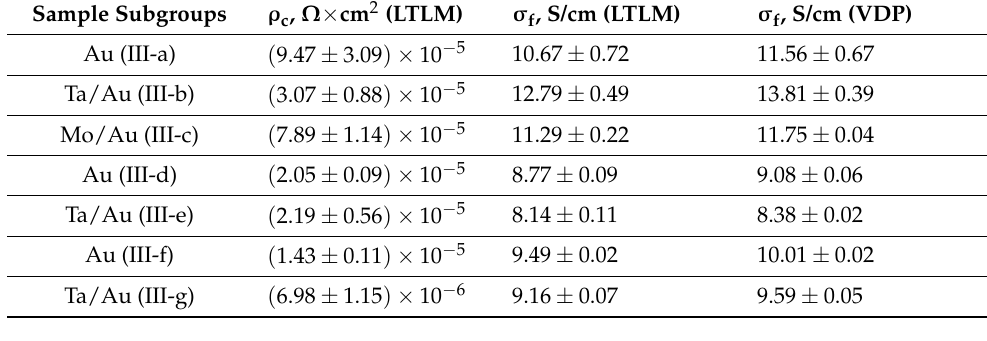
Table 2. Measurement results of specific electrical contact resistance and specific electrical conductivity of diamond film, based on different micro-structures and metallization metals. Sample Subgroups